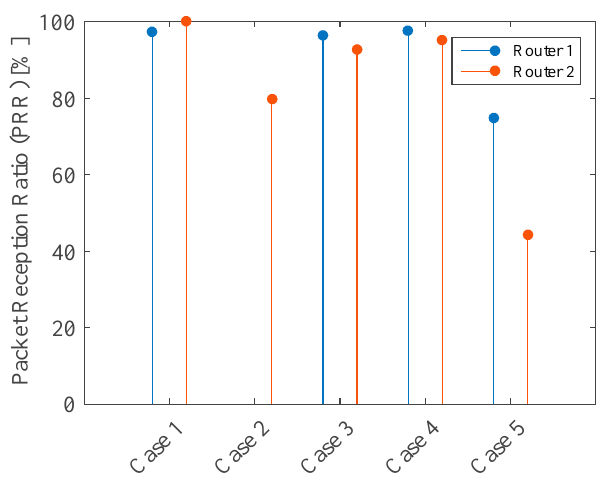
Figure 20. Graphical comparison of the five cases tested in case study A